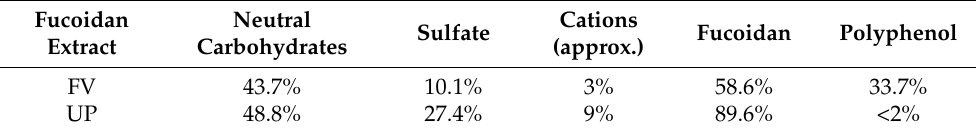
Table 1. Description of Fucus versiculosus (FV) and Undaria pinnatifida (UP). Fucoidan Neutral Extract Carbohydrates